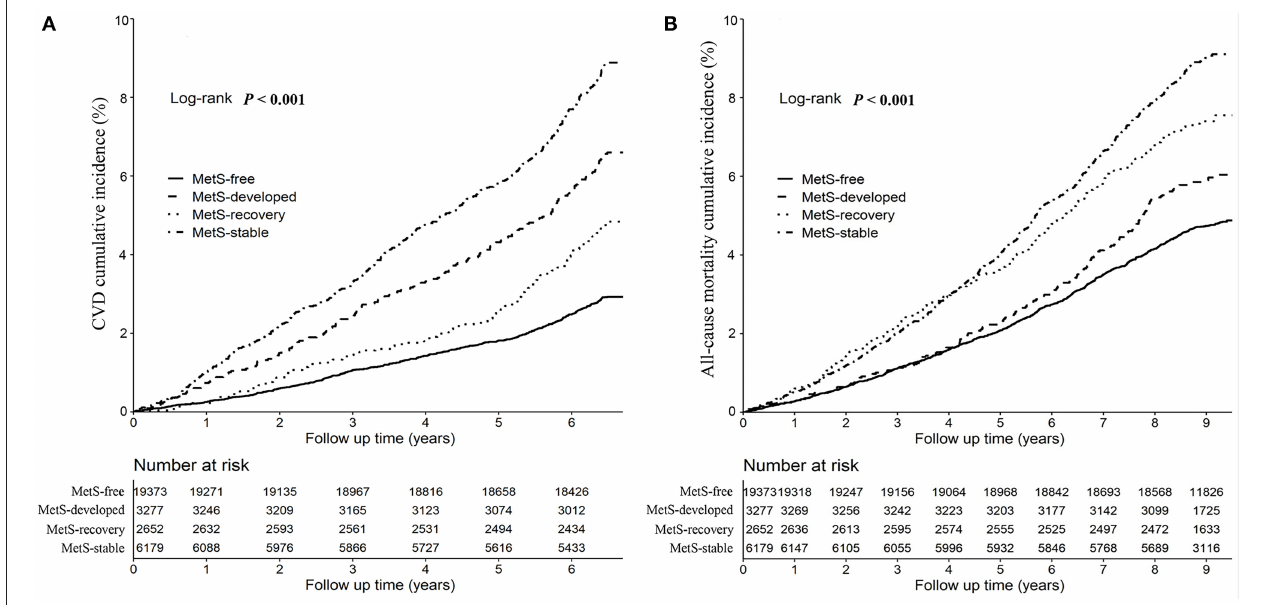
FIGURE 2 | Kaplan-Meier cumulative incidence curves of cardiovascular disease (A) and all-cause mortality (B) by the dynamic patterns of MetS. Cardiovascular disease was the composite of myocardial infarction, stroke, and heart failure. CVD, cardiovascular disease; MetS, metabolic syndrome.